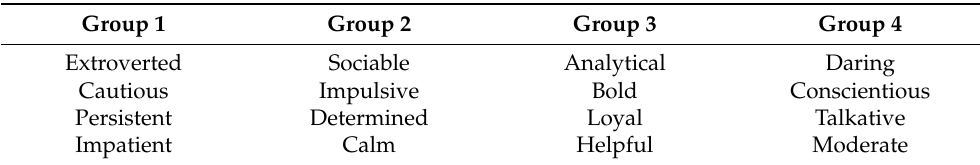
Table 1. Examples of the adjective groups in the dominance, influence, steadiness, and compliance (DISC) personality test. Group 1 Group 2 Group 3 Group 4 Extroverted Sociable Analytical Daring Cautious Impulsive Bold Conscientious Persistent Determined Loyal Talkative Impatient Calm Helpful